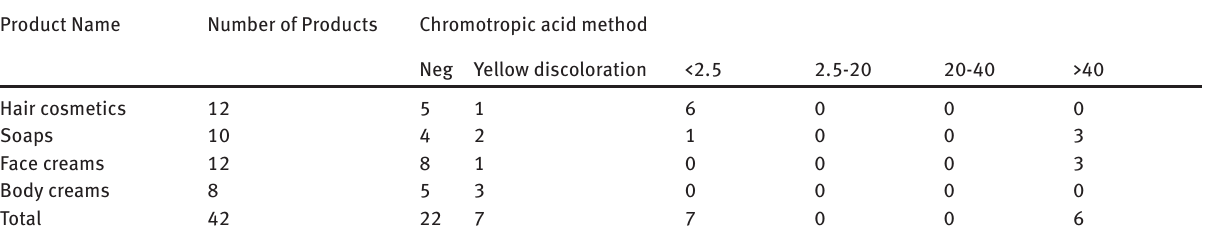
Table 3 . Results of chromotropic acid method in the investigated Lithuanian cosmetics (in